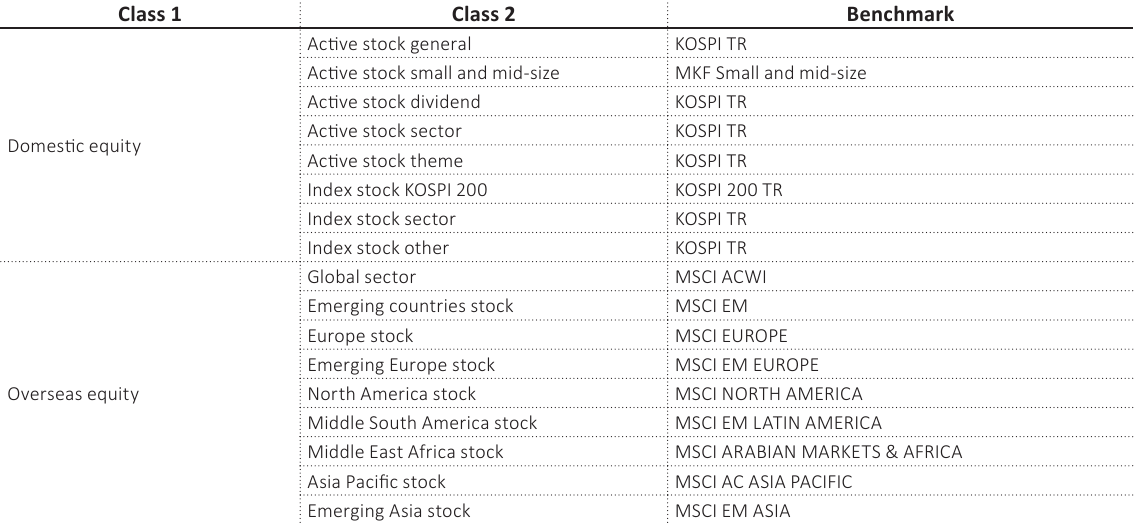
Table 2. The benchmark rate of